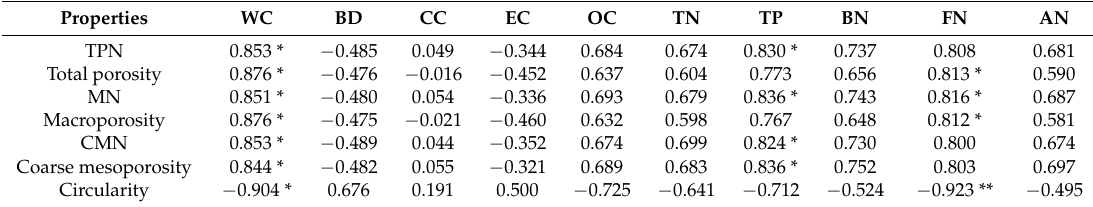
Table 3. Correlation analysis between soil pore characteristic and soil properties among three